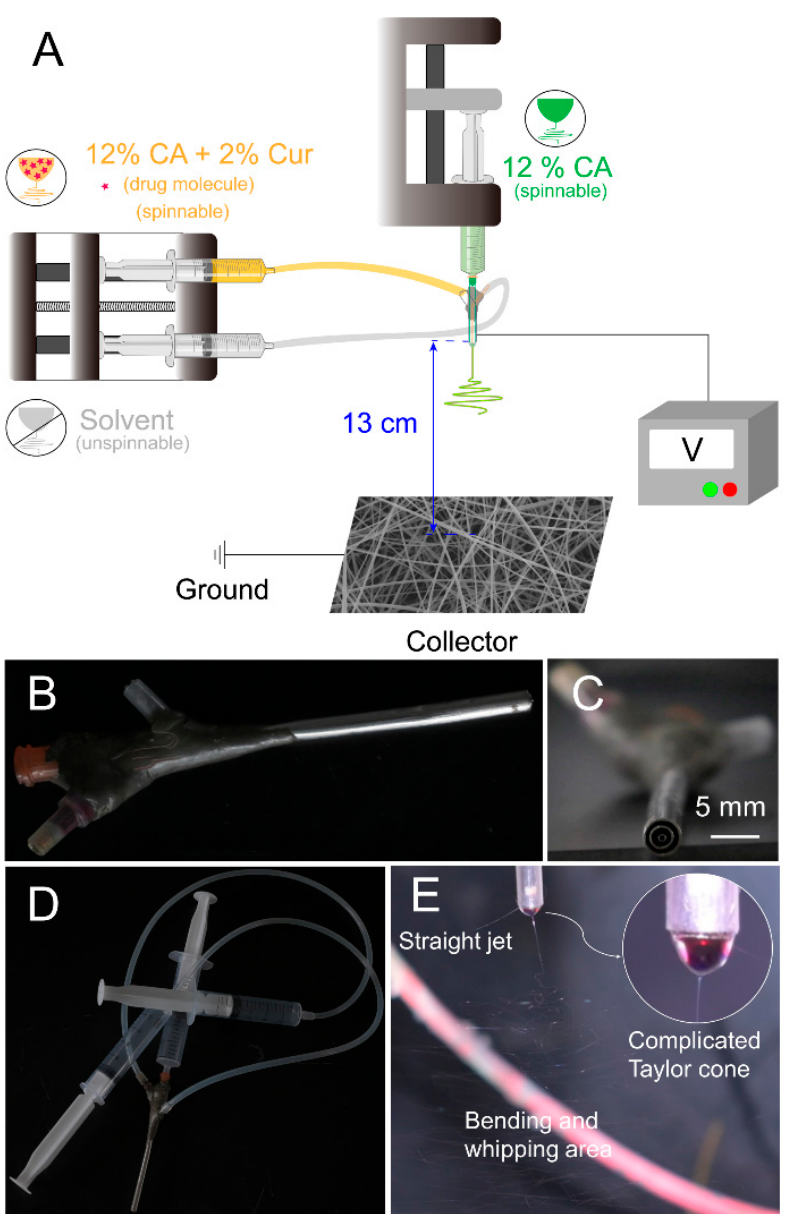
Figure 2. Scheme of modified triaxial electrospinning and its components. ( A ) Implementation of the modified triaxial electrospinning, consisting of pump, syringes, spinneret, aluminum foil collector, and power supply. ( B ) Homemade triaxial spinneret. ( C ) Partial enlargement of the head of the spinneret. ( D ) Connection between syringes and homemade triaxial spinneret by using transparent silicone tubes. ( E ) Modified triaxial electrospinning working process with a complicated Taylor cone (a clear triaxial structure) shown in the right corner.